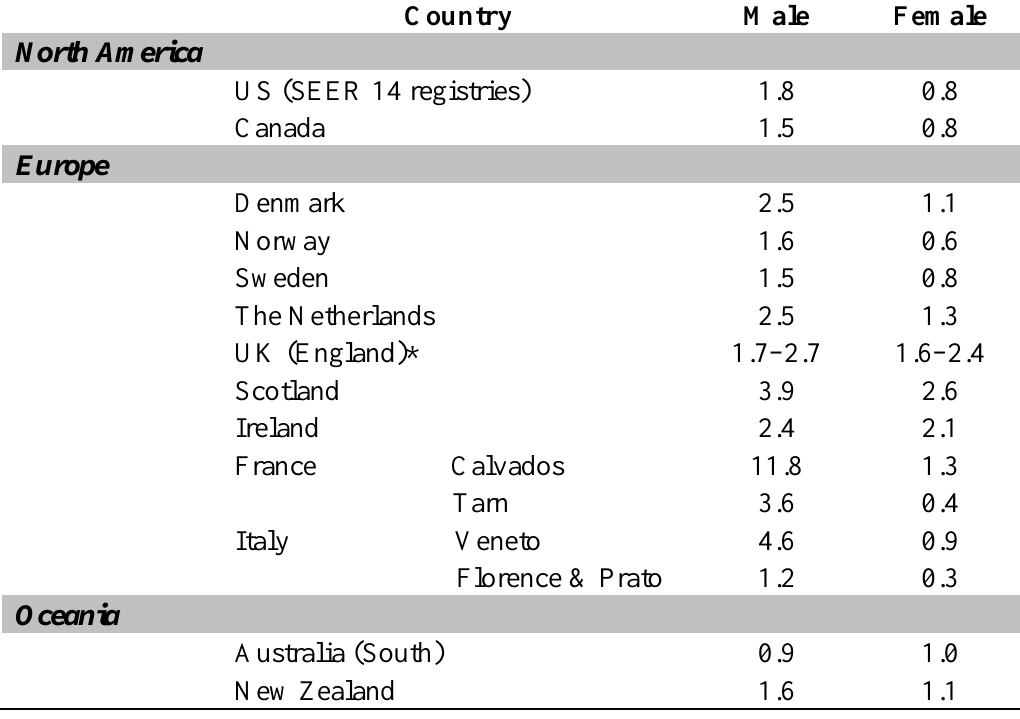
Table 2. Incidence of esophageal squamous cell carcinoma in westernized countries. Country